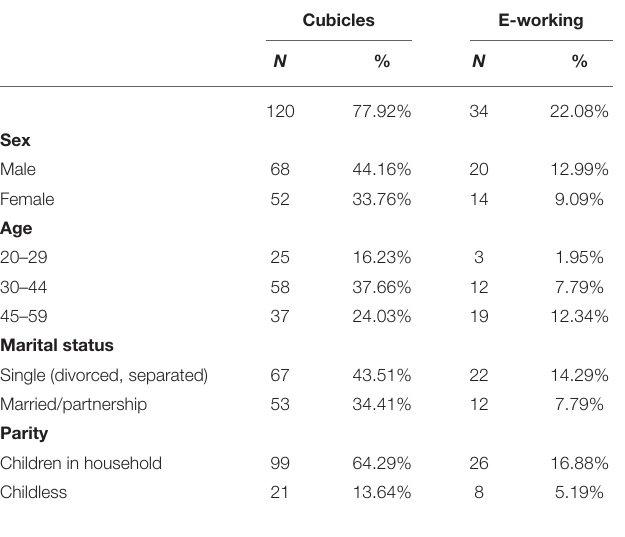
TABLE 1 | Socio-demographic